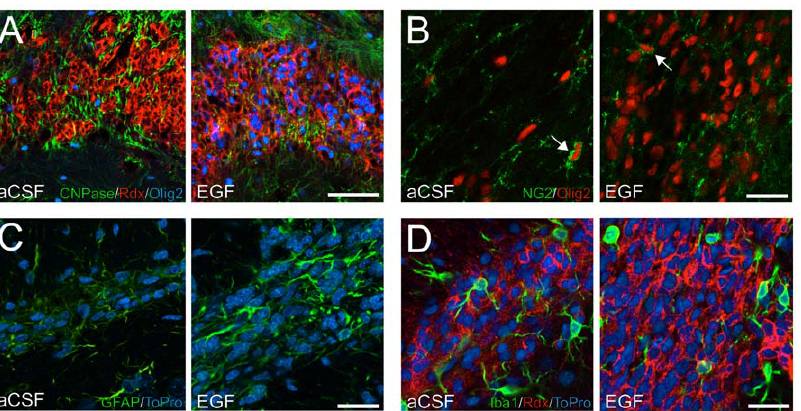
Figure 8. Expression of oligodendrocyte, astrocyte, and microglia markers in the rostral migratory stream. ( A, B ) Immunofluorescence staining against CNPase and NG2 show expression of oligodendrocyte lineage markers in the aCSF and EGF-treated rostral migratory stream (RMS). NG2 + /Olig2 + cells were occasionally found under both conditions (arrows in B). ( C ) The appearance of the GFAP expressing cells was more reactive, with less regular and thicker processes, in the EGF-treated RMS compared to control. ( D ) Microglia were visualized based on Iba1 immunoreactivity. No differences between control and EGF-treated RMS were found in cell distribution or shape. Scale bar in A=50 m m and B–D=20 m m.